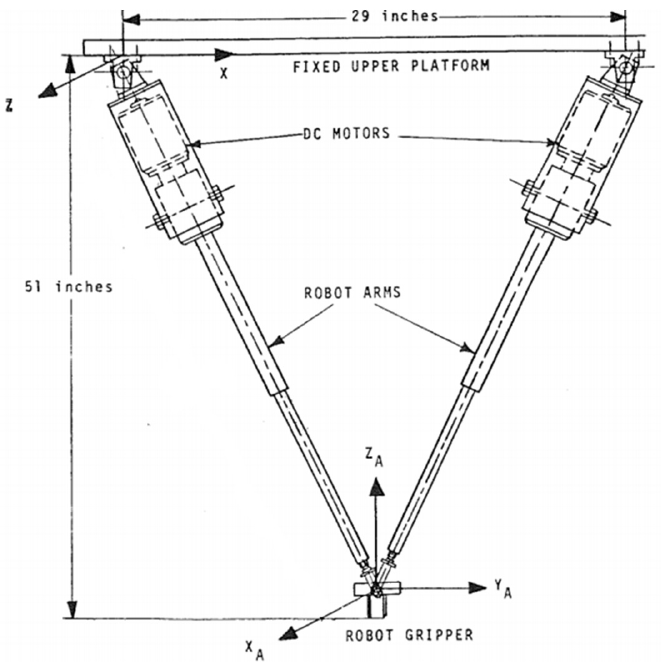
Figure 1. Architecture of the 2 DOF CKCM manipulator.